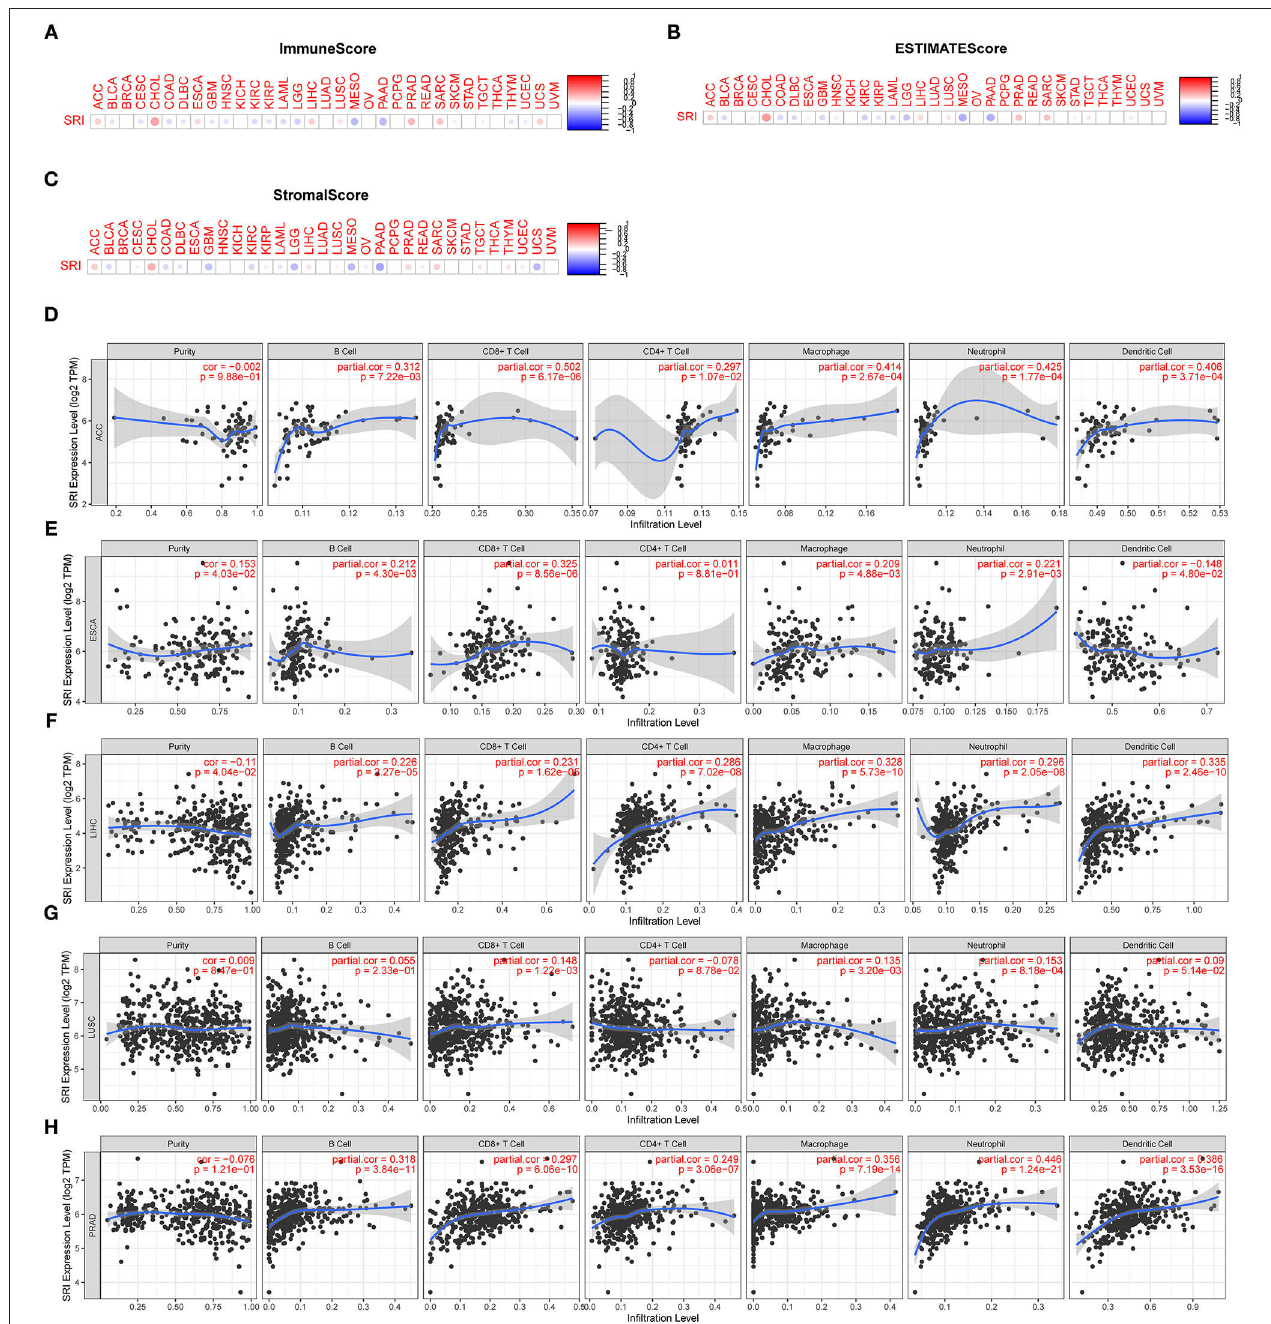
FIGURE 9 | Correlation between the SRI gene expression and tumor immune microenvironment in TCGA. (A–C) The SRI expression associated with ImmuneScore, ESTIMATEScore, and StromaScore in different cancers. The red dots indicate a positive correlation and the blue dots indicate a negative correlation. (D–H) Correlation of the SRI expression with immune infiltration level in adrenocortical carcinoma (ACC), ESCA, LIHC, lung squamous cell carcinoma (LUSC), and PRAD in TIMER database.